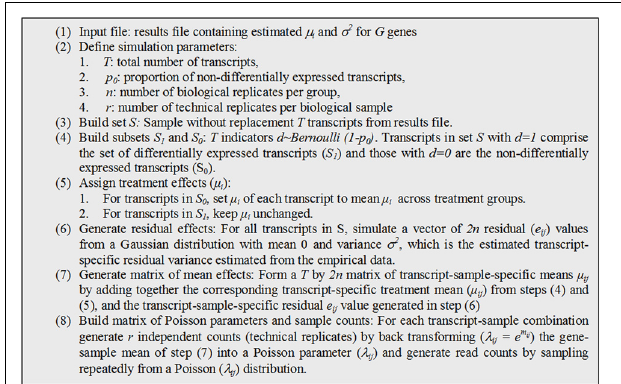
FIGURE 1 | Algorithm used to simulate counts from existing estimates of model parameters.